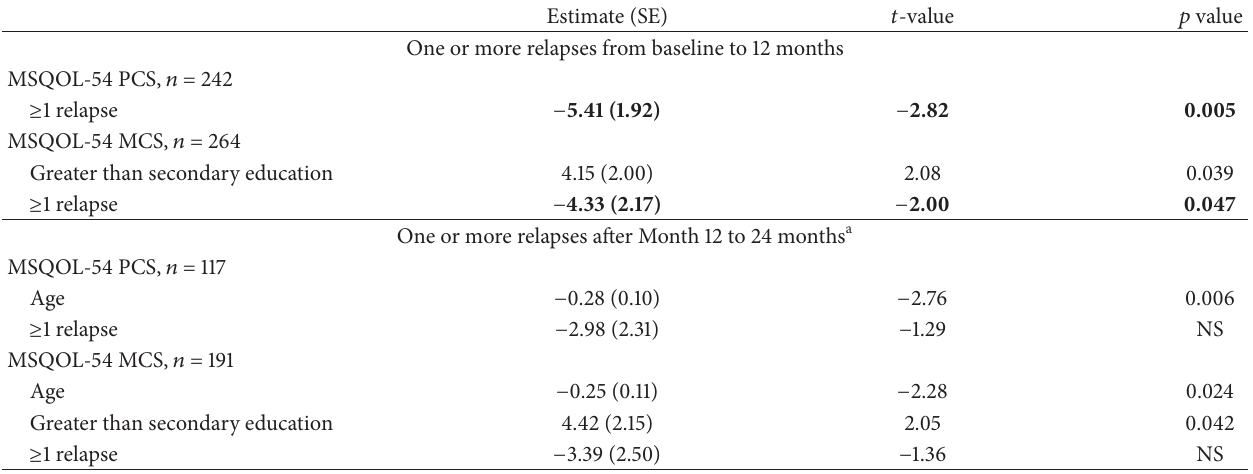
Table 4: Results of multivariable analyses: unique associations of relapse occurrence with follow-up MSQOL-54 PCS and